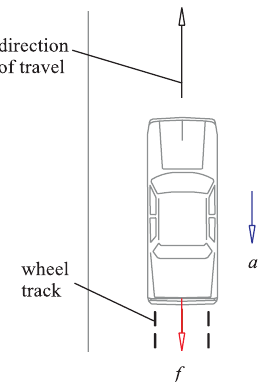
Fig. 1. Traveling at level terrain and straight roadway